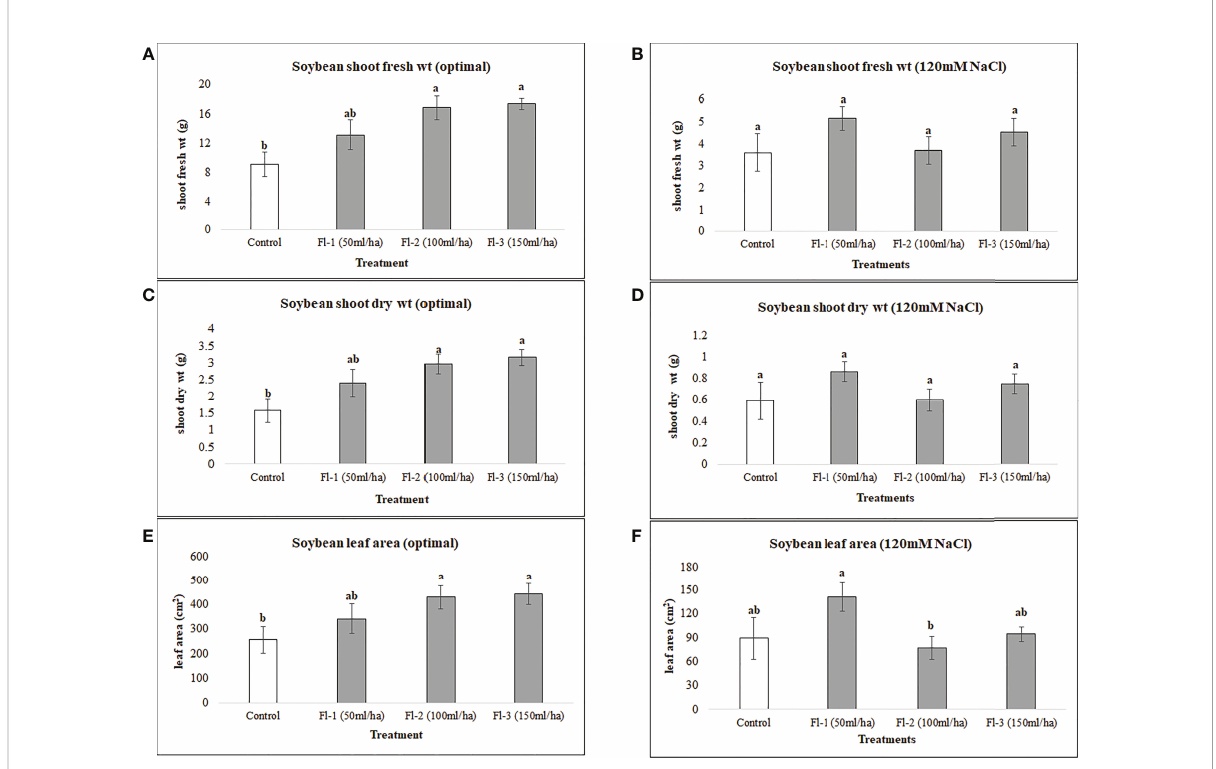
FIGURE 1 Soybean above ground biomass affected by fl avonoids (A) shoot fresh wt - optimal (B) shoot fresh wt – 120 mM NaCl (C) shoot dry wt - optimal (D) shoot dry wt – 120 mM NaCl (E) leaf area - optimal (F) leaf area – 120 mM NaCl. The data represents the mean values of 8 replications (n=8) ± standard error. Different letters indicate values determined by Tukey ’ s multiple mean comparison to be signi fi cantly different (p< 0.05) from each